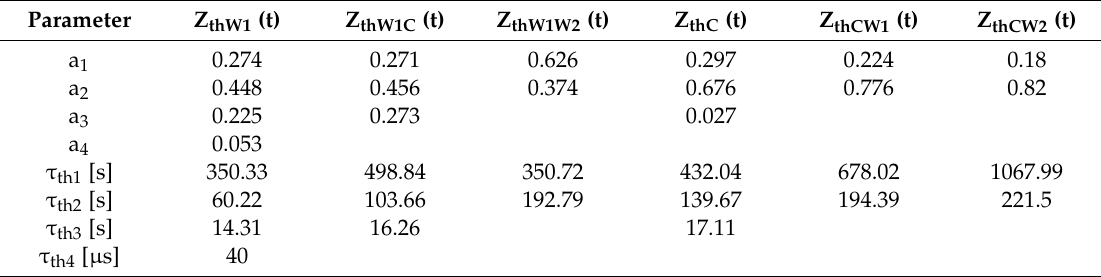
Table 3. Values of the parameters a i and τ thi of the selected self-transient and mutual transient thermal impedances in a thermal model of a planar transformer.